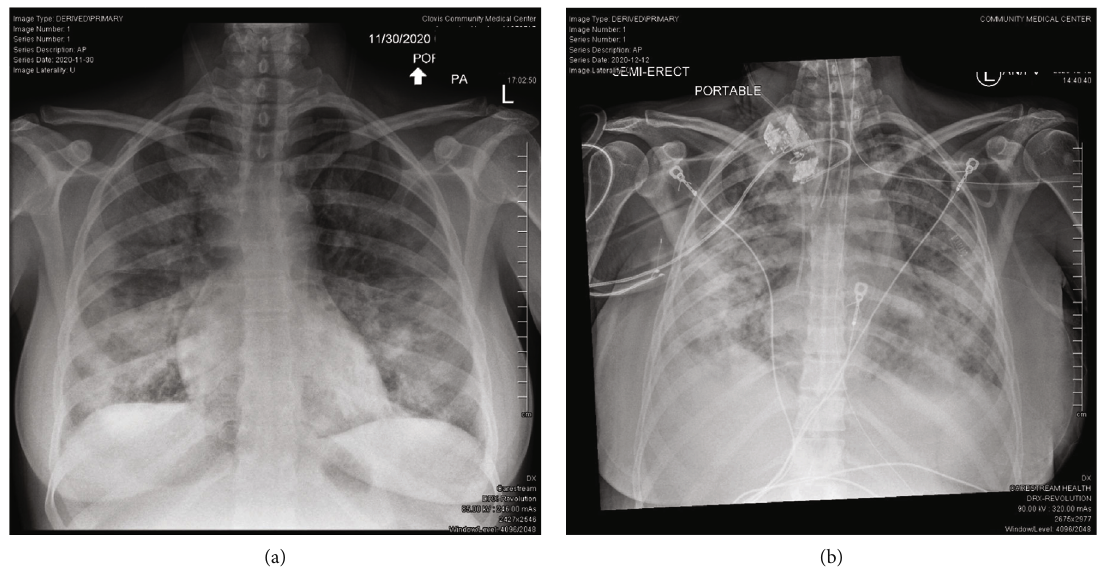
Figure 1: (a) Bilateral in fi ltrates on initial portable chest X-ray at her fi rst ED visit. (b) Progression of bilateral in fi ltrates on portable chest X-ray on hospital day